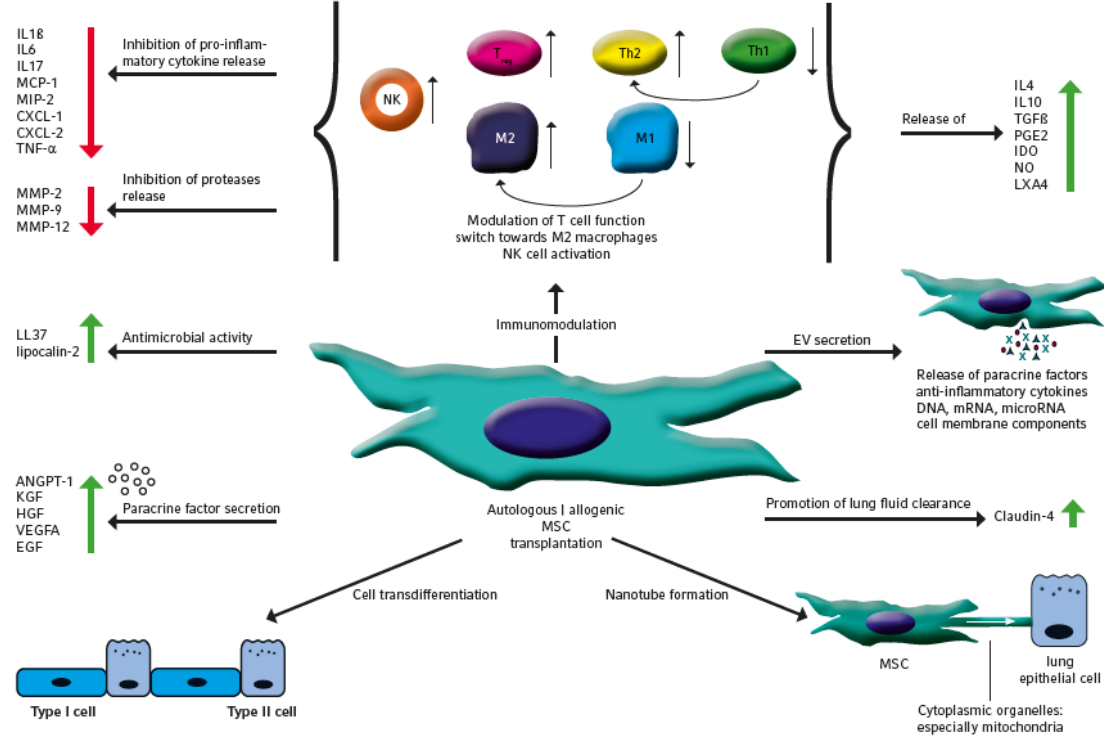
Figure 1. Multiple lung repair and regenerative functions of mesenchymal stem cells (MSC). Autologous or allogenic MSC from different rodent species and humans proved therapeutic efficacy in different preclinical lung disease models mostly studied in rodents. The graphic summarizes the multiple actions of MSC transplantation to the injured lung including cell transdifferentiation, secretion of paracrine factors, antimicrobial activity, immunomodulation, EV secretion, promotion of lung fluid clearance, nanotube formation and cell component transfer. MSC immunomodulation comprises T-cell, macrophage and NK cell function resulting in the augmented release of anti-inflammatory cytokines and beneficial factors, such as the inhibition of proteases as well as attenuation of